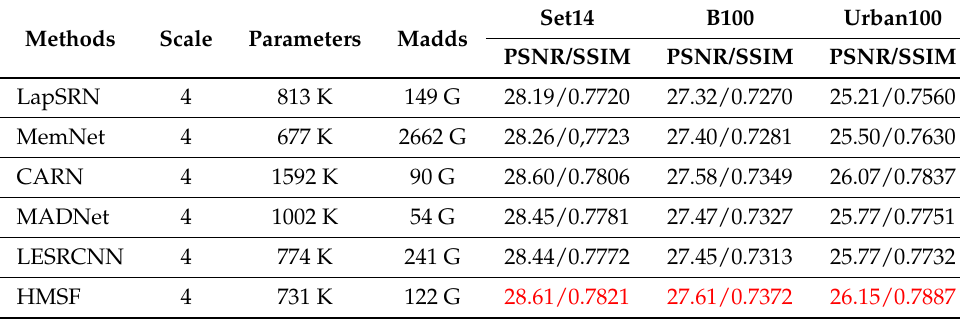
Table 11. Multi-adds compared between six similar methods at 4 × scale. Madds evaluated the number of multiplications and additions of the model, and evaluated the combination of parameters and Madds. Red text means the best performance.